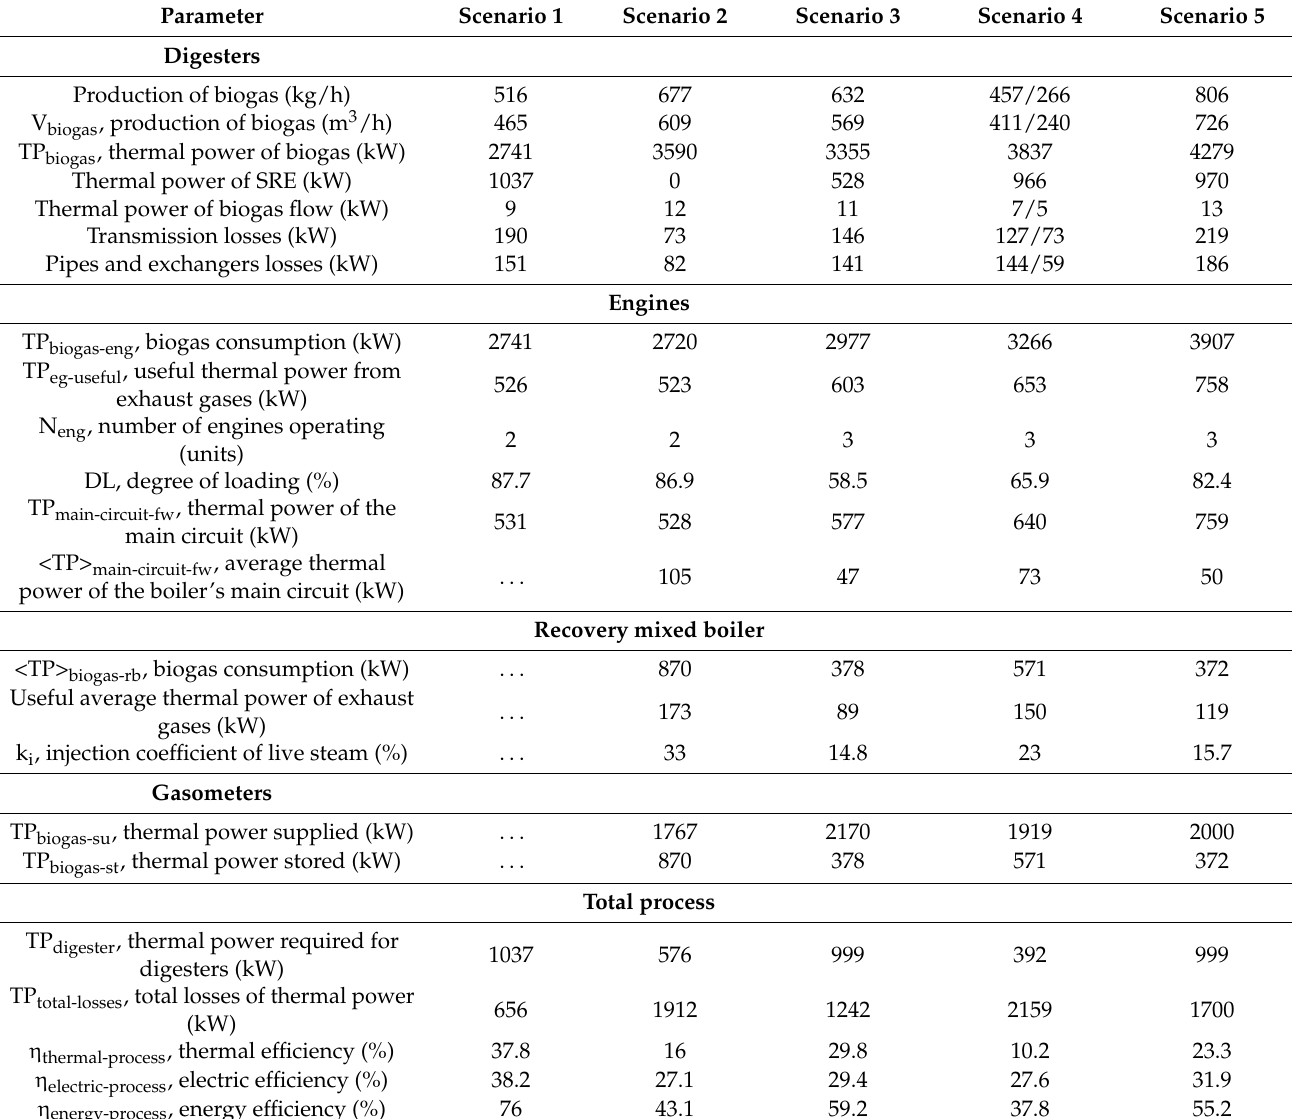
Table 7. Parameters obtained for the biogas line under assumptions of the economic balance case (Case